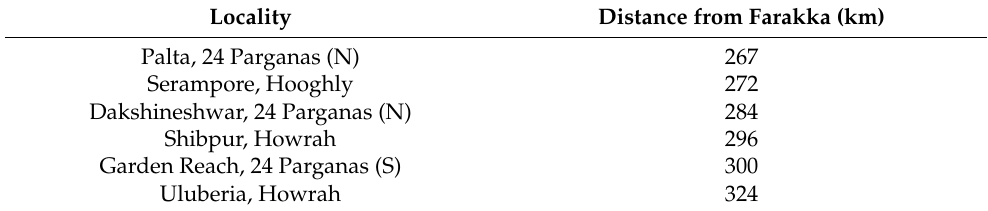
Table 3. Sampling locations.